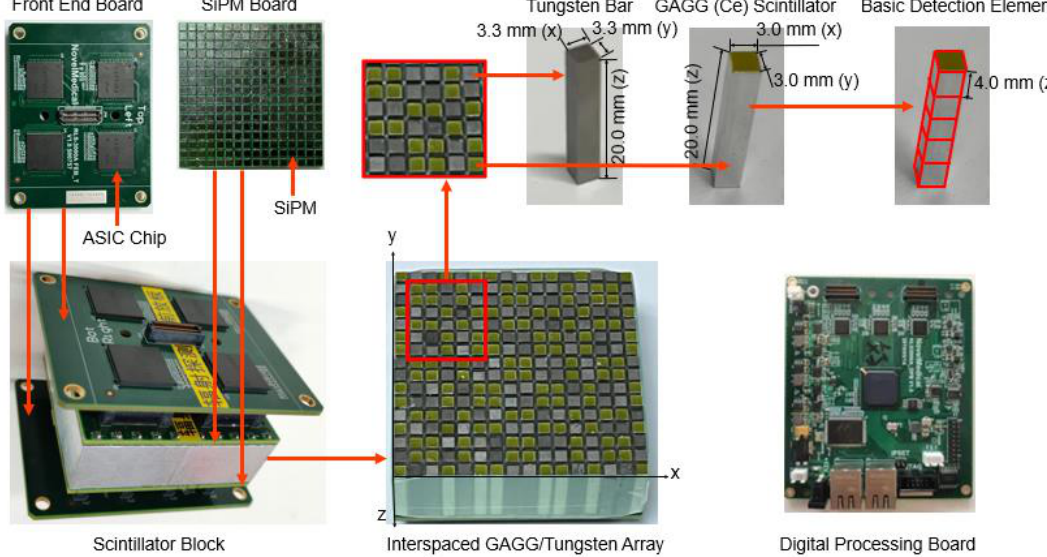
Figure 2. Gamma camera components: detector module and readout electronics.